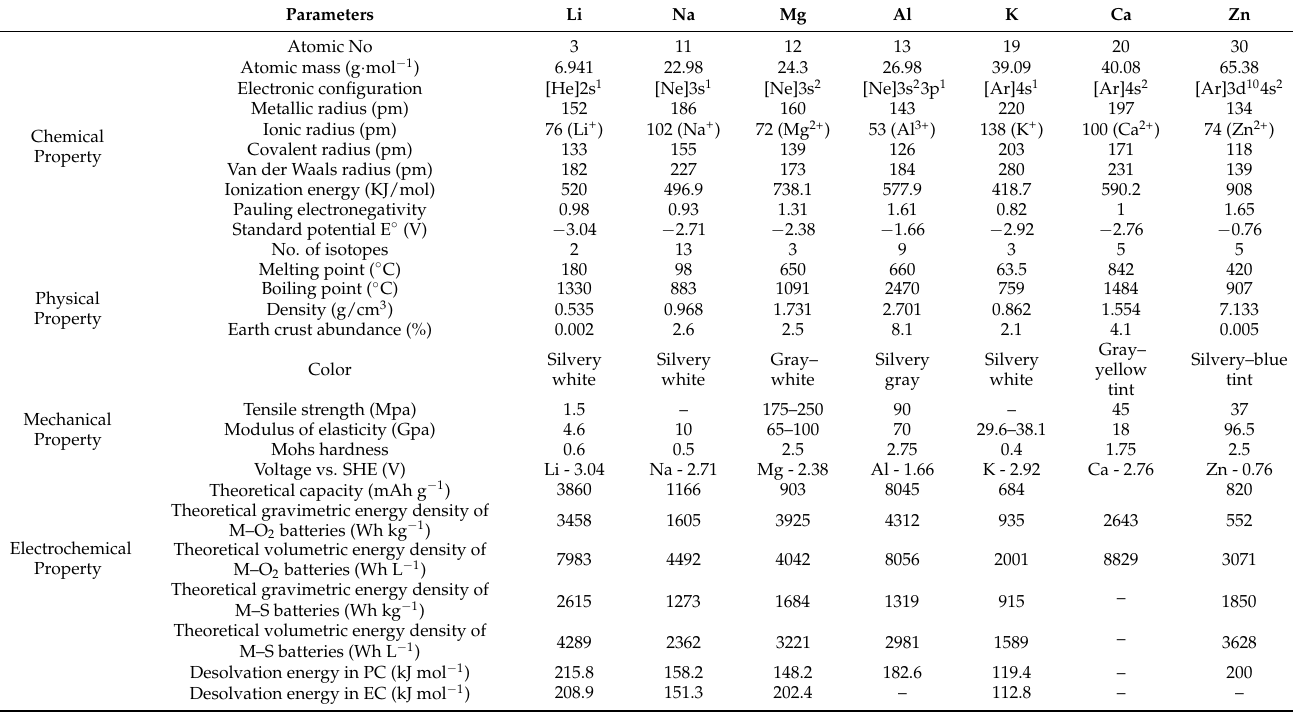
Table 1. Electrochemical characteristics and properties of precious battery